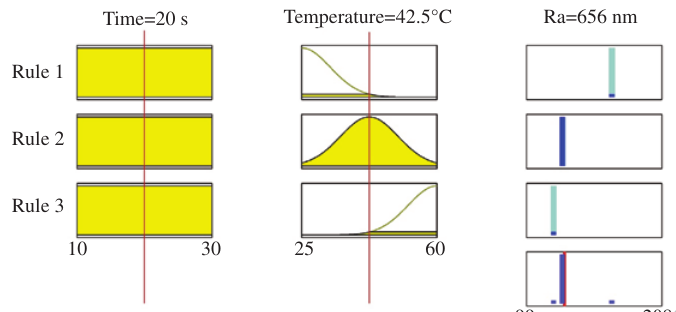
Figure 8 Proposed model’s rules.